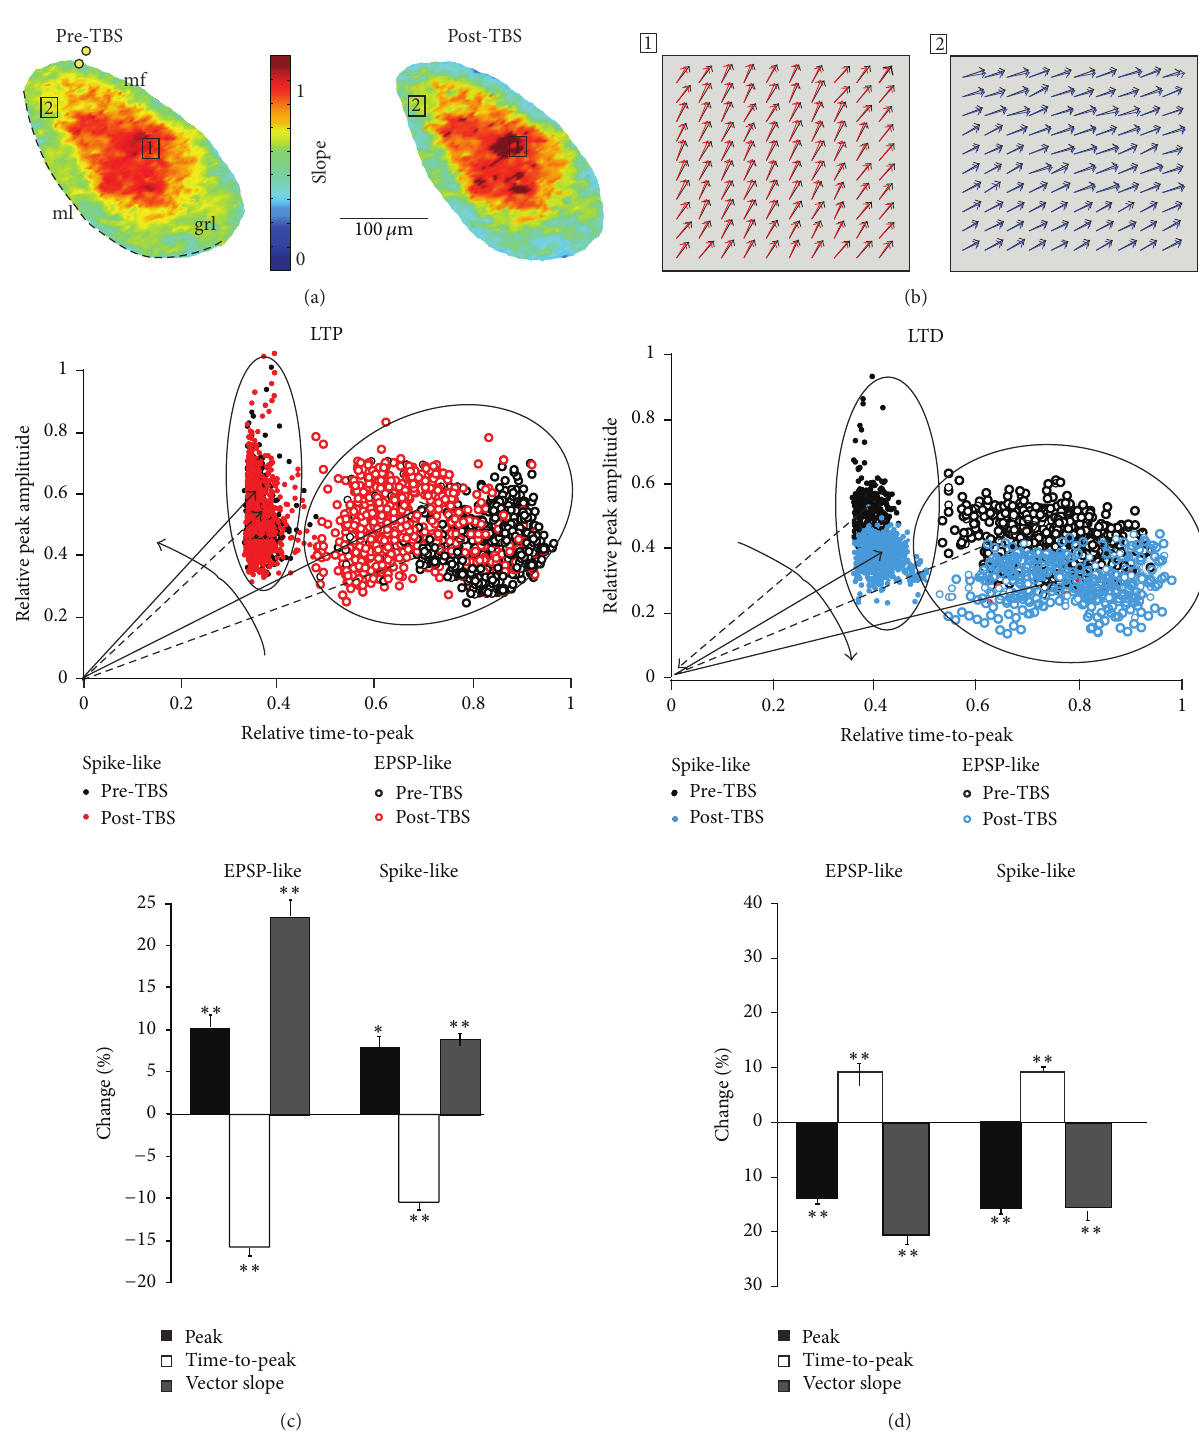
Figure 5: Activation vectors allow mapping LTP and LTD. (a) Vector maps of the granular layer before (left) and after TBS (right). The colors represent the vector slopes. (b) Individual vectors of pixels showing LTP in a high-responding region (square 1) were obtained before and after TBS (black and red vectors, resp.). Similarly, individual vectors of pixels showing LTD in a low-responding region (square 2) were obtained before and after TBS (black and blue vectors, resp.). (c) Up . Activation vectors undergoing LTP are divided into two clusters based on PCA (spike-like, filled circles; EPSP-like, empty circles). LTP increases the average vector slope (from dashed to filled arrows). Down . Activation vectors undergoing LTD are divided into clusters based on PCA (spike-like, filled circles; EPSP-like, empty circles). LTD decreases the average vector slope (from dashed to filled arrows). (d) The histograms summarize the effects of LTP and LTD on peak amplitude, time-to-peak, and vector slopes in the EPSP-like and spike-like clusters (Student’s 𝑡 -test statistical significance: ∗ 𝑝 < 0.05 ; ∗∗ 𝑝 < 0.01